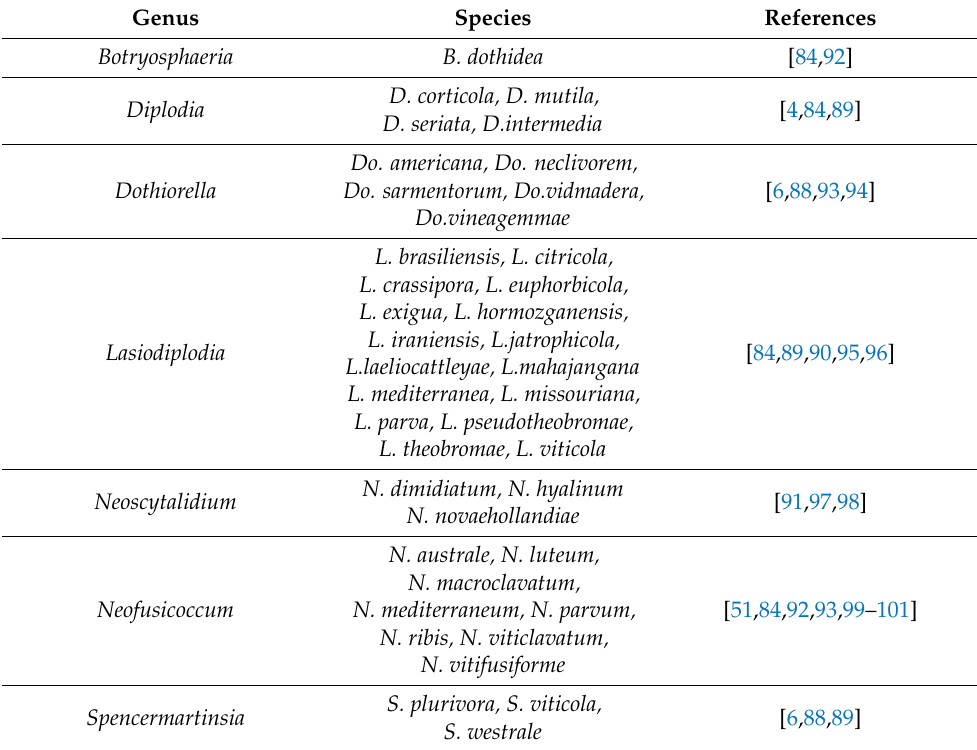
Table 3. Species of Botryosphaeriaceae involved in Botryosphaeria dieback. Genus